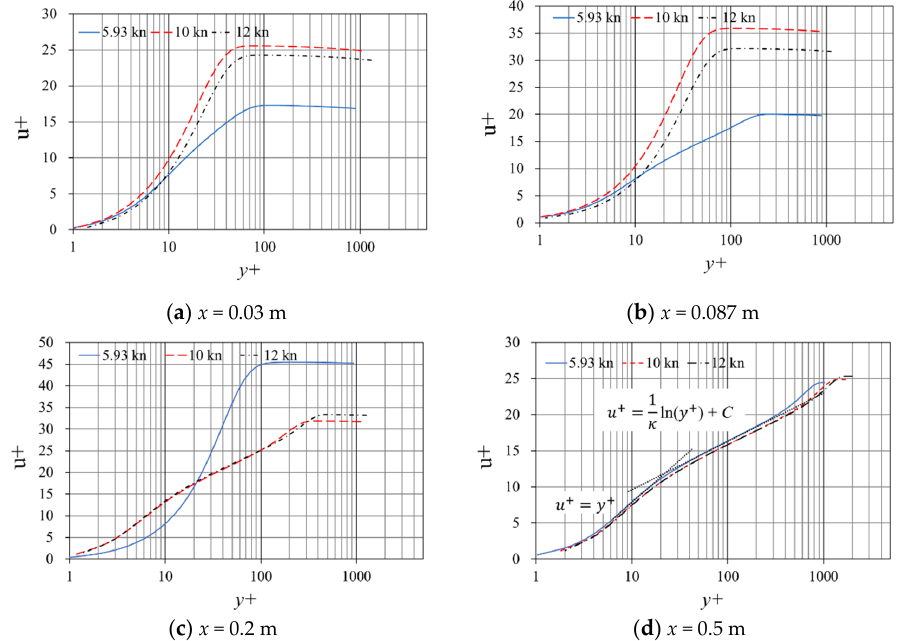
Figure 11. The velocity distribution within the boundary layer at different normal positions of the bow.